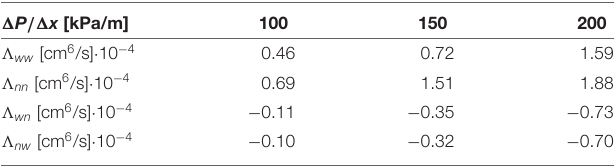
TABLE 2 | Integrated time correlation functions for case (A) and three different settings of the pressure drop across the network.